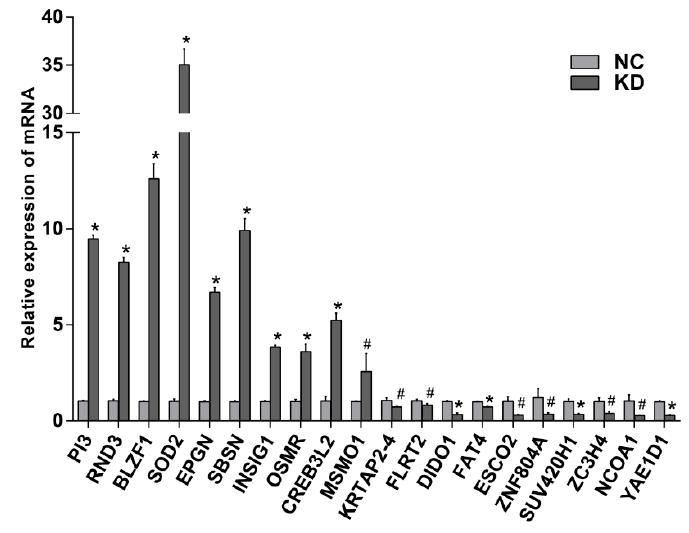
Figure 7. The mRNA expression levels of the top 20 most changed genes by qRT-PCR. NC, LV-NC-shRNA group; KD, LV-EBLN1-shRNA group. * p < 0.001 , # p < 0.05.